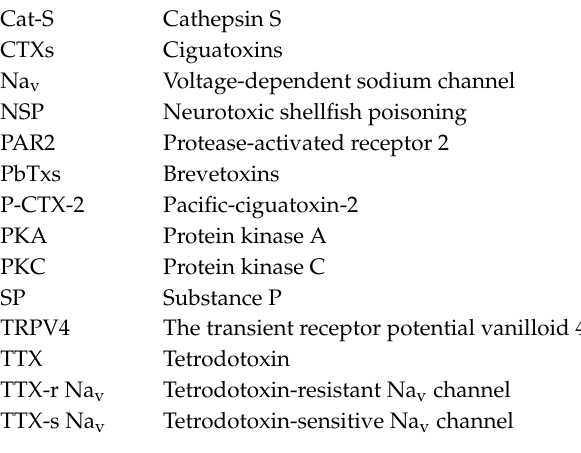
Table S1: Antagonists—their respective targets and the referenced